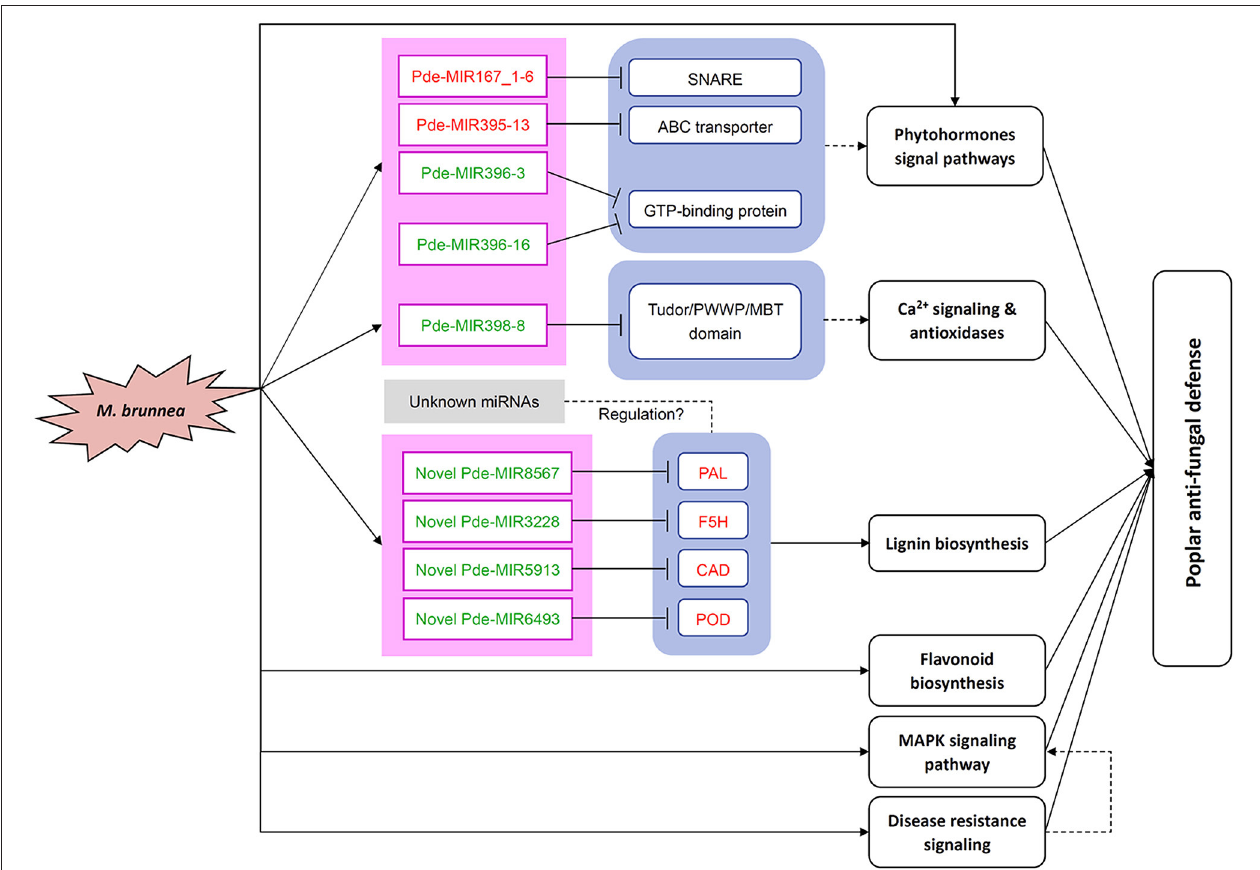
FIGURE 6 | Overview of miRNAs and genes regulation patterns in the poplar response to M. brunnea . The red letters are upregulated genes or miRNAs or pathways, and the green letters are downregulated genes or miRNAs or pathways. “ → ” represents induction of mentioned elements or pathway, while “ ⊥ ” stands for suppression. A dashed line indicates speculated pathways. SNARE, soluble N-ethyl-maleimide sensitive factor attachment adaptor protein receptor; ABC transporter, ATP-binding cassette transporter; PAL, phenylalanine ammonia-lyase; CAD, cinnamyl alcohol dehydrogenase; POD, peroxidase; F5H, ferulate-5-hydroxylase; MAPK, mitogen-activated protein